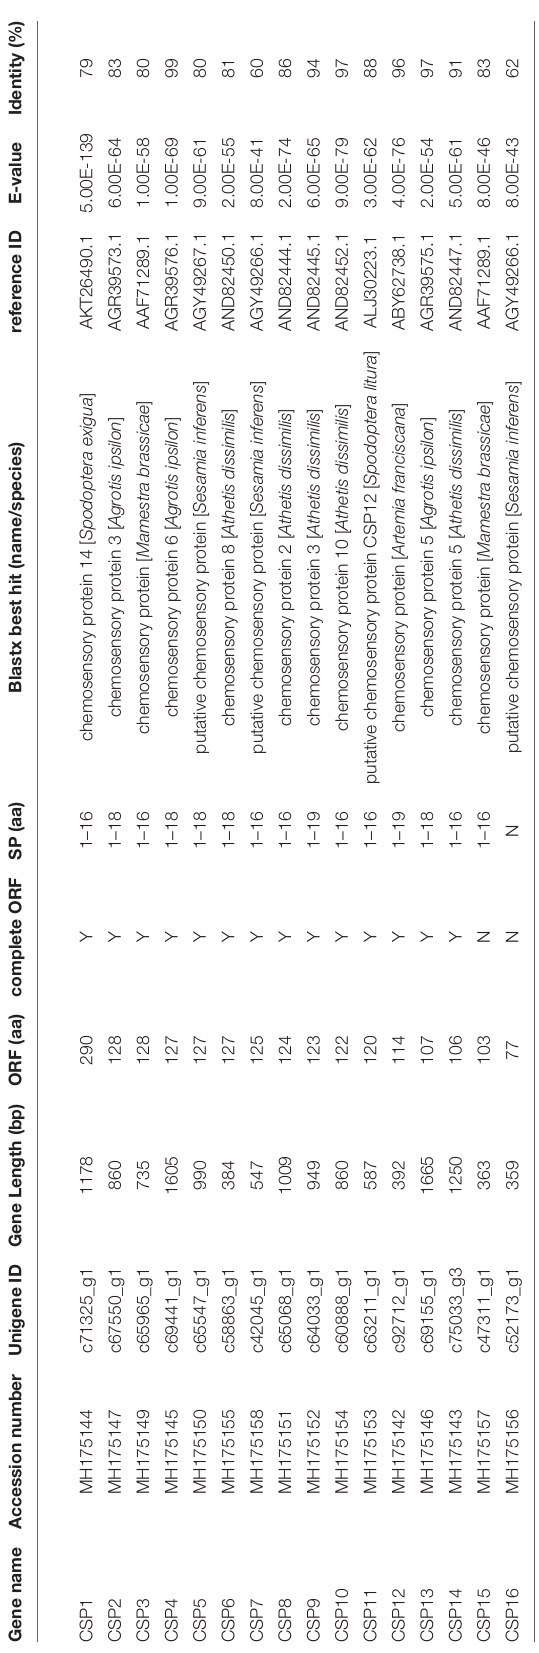
( Figure 7 ). Three CSP genes, CSP2 – 4 , were expressed in female brain. CSP8 was detected in male brain, and CSP10 – 12 , and CSP15 were detected in both female and male brains (original gel images of RT-PCR can be found in Supplementary Material 4